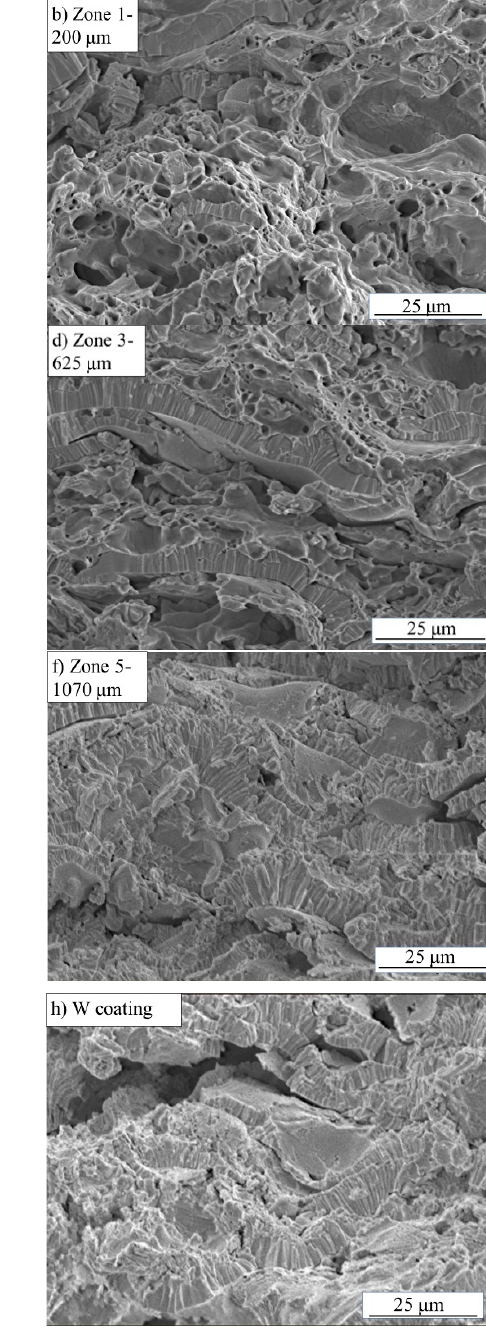
Figure 4. ( a – h ). Fracture surface of samples broken in three-point bending tests. Micrographs were recorded in zones of the interlayer at different distances from the substrate and in the W coating. Labels indicate the zones and the distance from the substrate, expressed in microns, red arrows indicate some unmolten particles. To make the identification of the areas of W and Cu in ( c ) easier, they are evidenced by markers.